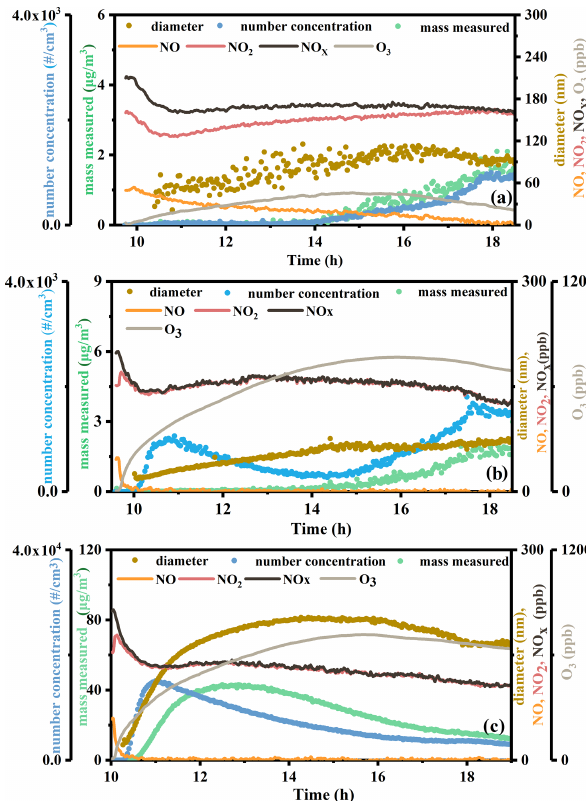
Figure 1. Reaction profiles of photooxidation of n -dodecane (a) , 1,3,5-TMB (b) , and mixed AVOCs (c) under NO x conditions in summer. The concentrations of mass and number concentration of particles are shown on the left axes, while the diameter of particles and concentrations of NO, NO 2 , NO x , and O 3 are shown on the right